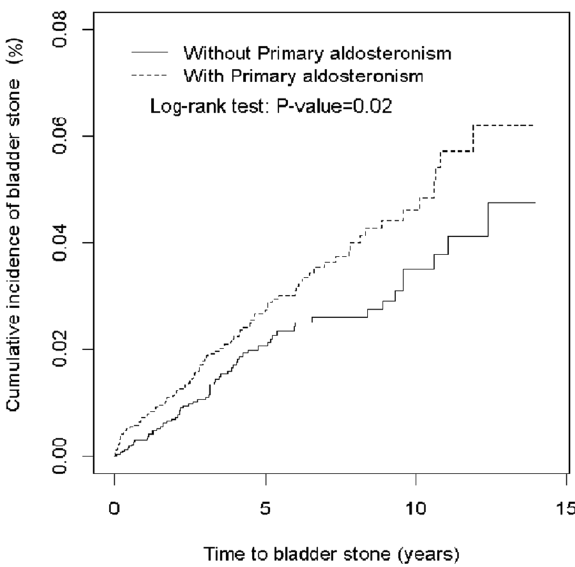
Figure 1. Cumulative incidence rate (%) of bladder stones in the PA cohort and the comparison cohort during the period of